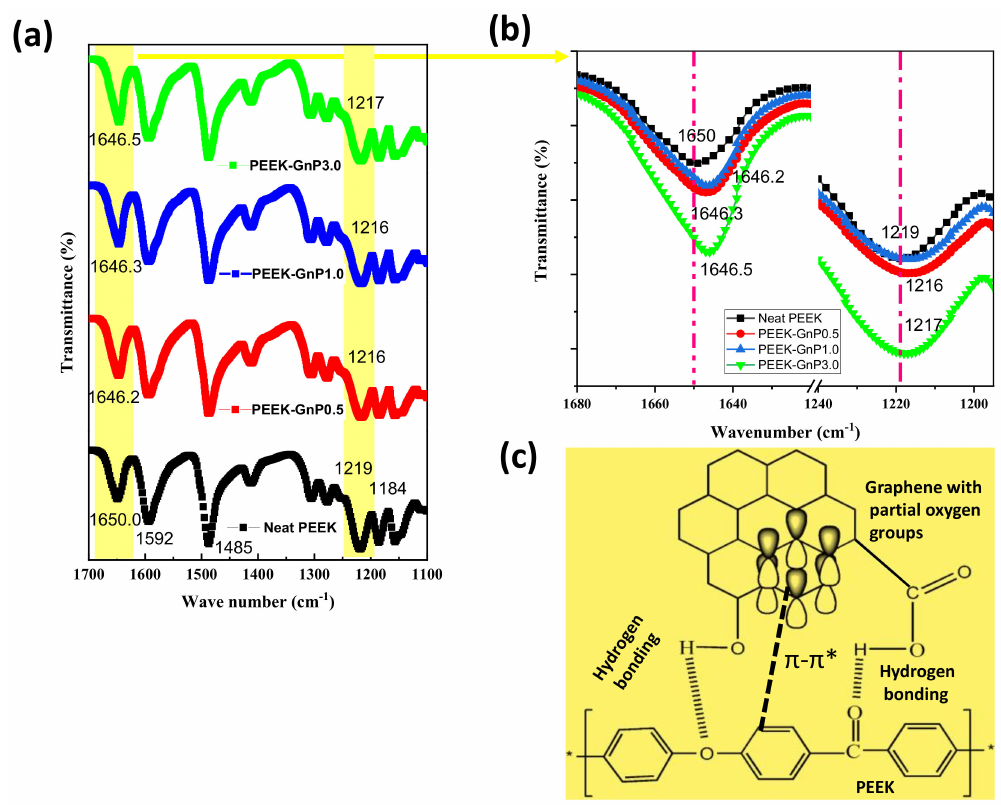
Figure 3. ( a ) ATR-FTIR spectra of the neat PEEK and PEEK–GnP nanocomposites with different filler contents. The identification of the PEEK footprints is included. ( b ) FTIR stretching modes of carbonyl (-C=O) and ether (C–O–C) groups before and after GnPs loading. ( c ) A schematic representation of the hydrogen bonding and π – π * interactions between graphene and PEEK